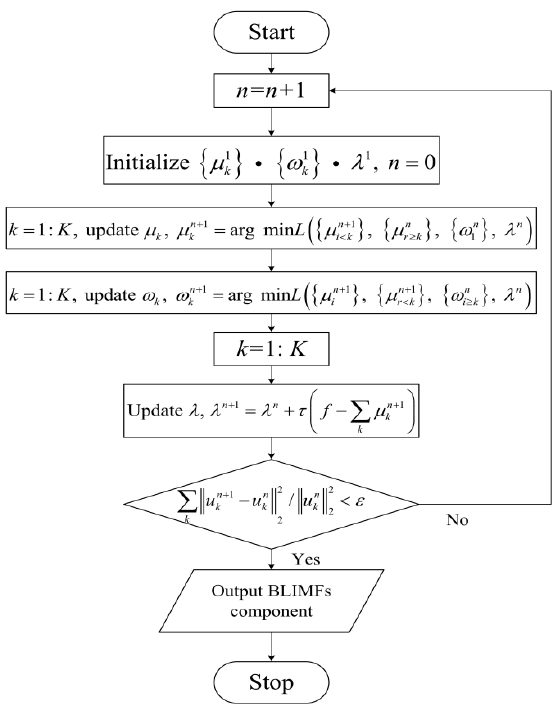
Figure 1. Illustration of the VMD algorithm.